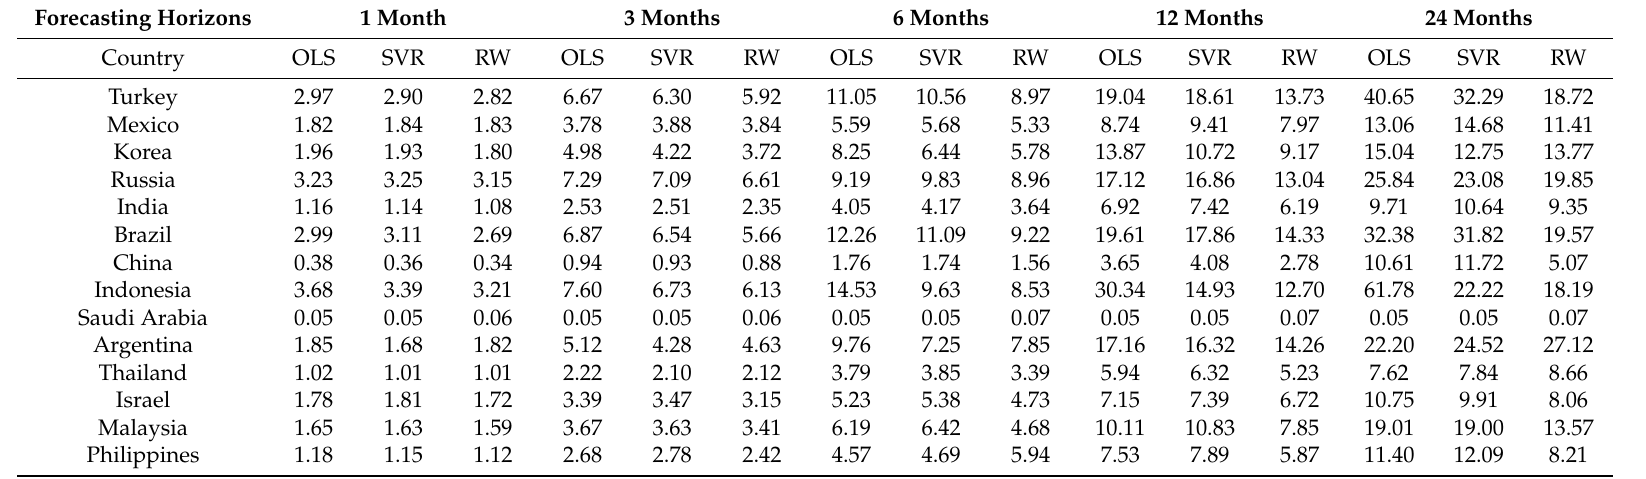
Table 3. Exchange rate out-of-sample forecasting